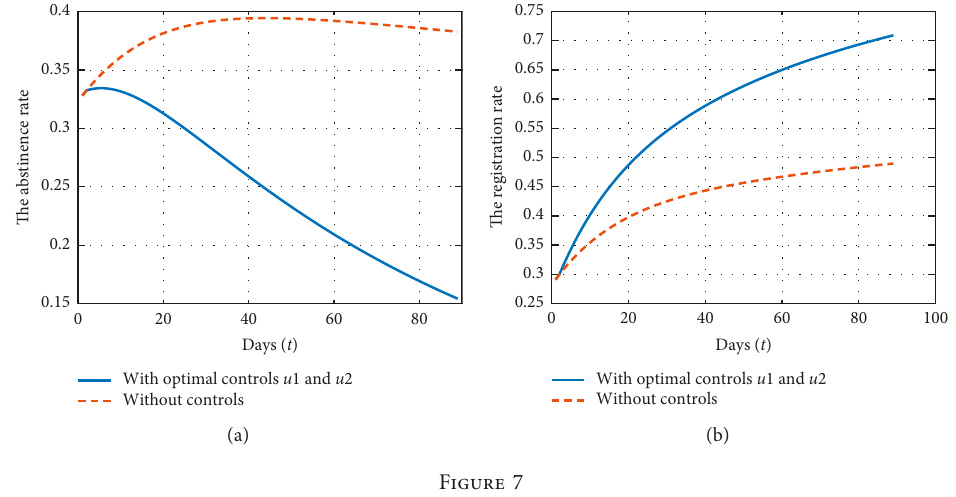
With optimal controls u 1 and u 2 Without